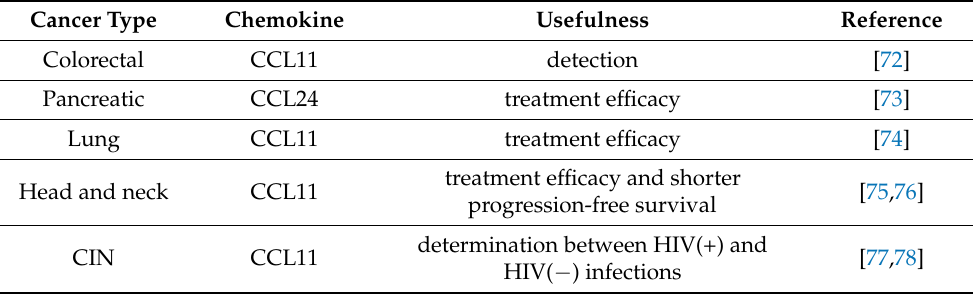
Table 2. Usefulness of eotaxins in different types of